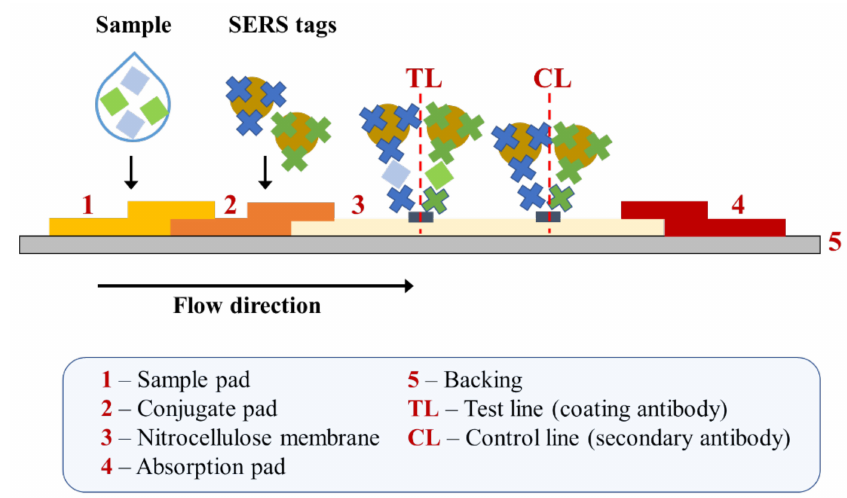
Figure 7. Schematic representation of lateral flow assay combined with SERS for biomarker detection based on antigen–antibody interactions (based on